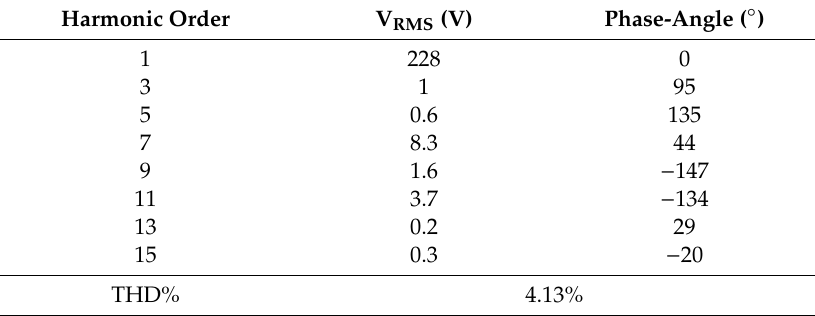
Table 3. Harmonic spectrum of the power grid voltage measured at the power electronics laboratory used in the simulation